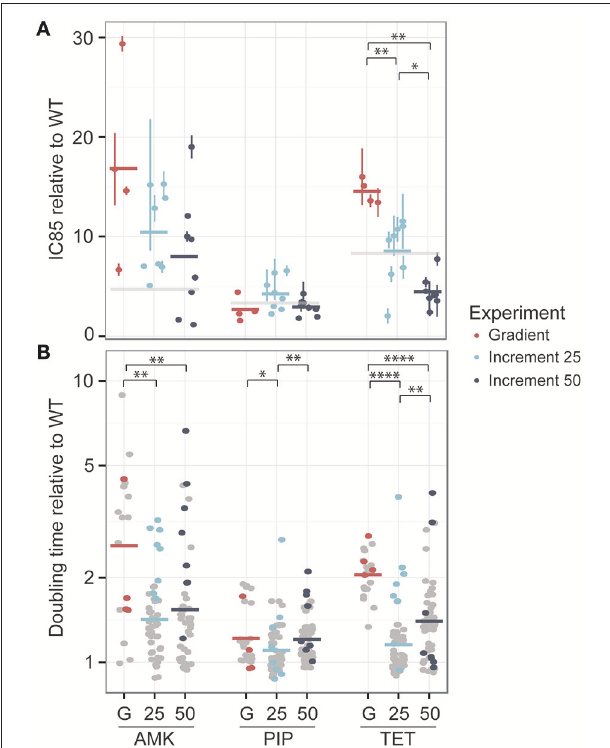
FIGURE 3 | Phenotypic changes in drug resistance and growth rate after the adaptive laboratory evolution experiment. (A) The fold-increase of the IC 85 compared to the wild type (WT) is displayed for each drug. The evolved resistance levels are not significantly different for amikacin (AMK) and piperacillin (PIP) across different experimental setups, which are referred to as G for the gradient approach, 25 for the 25% increment and 50 for the 50% increment method. However, strains adapted to tetracycline (TET) display significant changes in drug resistance. The clinical breakpoint normalized to fold-increase to the media adapted wild type (WT) of each drug is marked with a light gray panel. (B) The doubling time relative to the wild type is shown for the same isolated colony used for the IC 85 determination as well as for six additional colonies, colored in gray. A significantly lower doubling time for the 25% increment lineages compared to the gradient evolved lineages can be observed for all drugs. * P < 0.05, ** P < 0.01, *** P < 0.001, **** P <